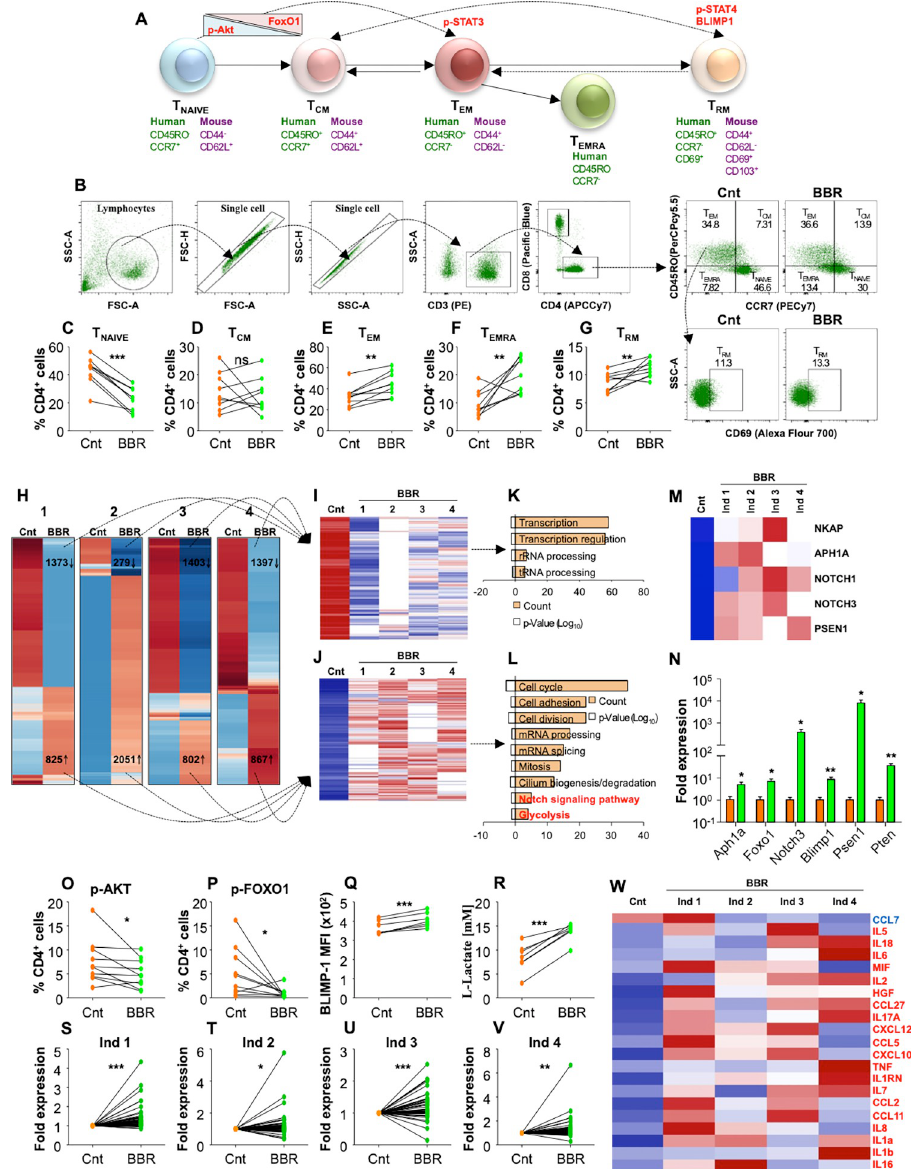
Fig 3. BBR treatment enriches human CD4 + memory T cells by regulating NOTCH/PTEN/Akt/FOXO1 pathway. (A) Schematic representation of T cell differentiation into T EM , T CM and T RM memory subsets. (B-G) Human PBMCs isolated from 7 PPD + healthy individuals were ex vivo stimulated with CSA and treated with BBR (10 μ g/ml) for 48 h followed by surface staining with α -CD3 (PE), α -CD4 (APCCy7), α -CD8 (Pacific Blue), α -CD45RO (PerCPCy5.5), α - CCR7 (PECy7) and α -CD69 (Alexa Flour 700) (B) Gating strategy employed to depict the different memory T cell subsets. Percentage of (C) CD4 + T NAIVE cells, (D) CD4 + T CM cells, (E) CD4 + T EM cells, (F) CD4 + T EMRA cells and (G) CD4 + T RM cells. (H) Whole proteome profiling of untreated and BBR treated human PBMCs derived from 4 PPD + healthy individuals. Heat map representation of the differentially expressed proteins (Log2 fold, n = 3). Common proteins in all the individuals that are (I) downregulated and (J) upregulated upon BBR treatment. Biological processes that are (K) downregulated and (L) upregulated upon BBR treatment. (M) Notch signalling pathway associated proteins which were upregulated in human PBMCs upon BBR treatment. (N) RT-PCR of genes related to Notch signaling pathway. (O) Human CD4 + T cells expressing p-AKT and (P) human CD4 + T cells expressing p-FOXO1. (Q) MFI of human CD4 + T cells expressing Blimp-1. (R) Extracellular L-Lactate quantification in untreated and BBR treated human PBMCs. (S-W) represents multiplex cytokines assay upon BBR treatment in human PBMCs of derived from 4 PPD + healthy individuals (refer methodology). (S-V) Fold expression changes of 46 cytokines upon BBR treatment in different individuals. (W) Heat map of common differentially expressed cytokines. In H , I , J , M , and W ,